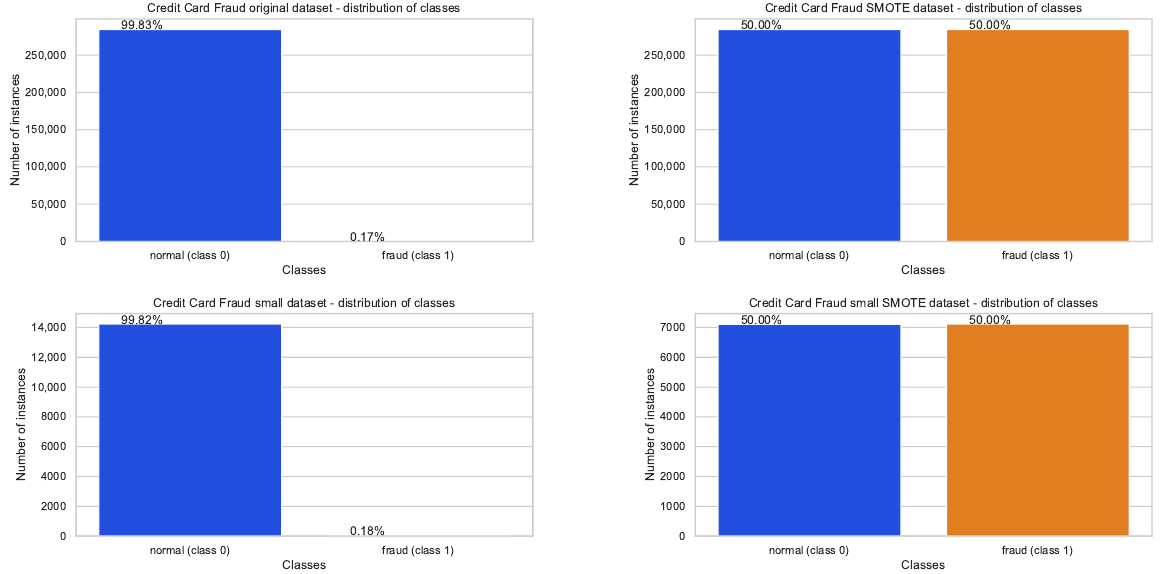
Figure 1. Distribution of classes and number of instances in four employed